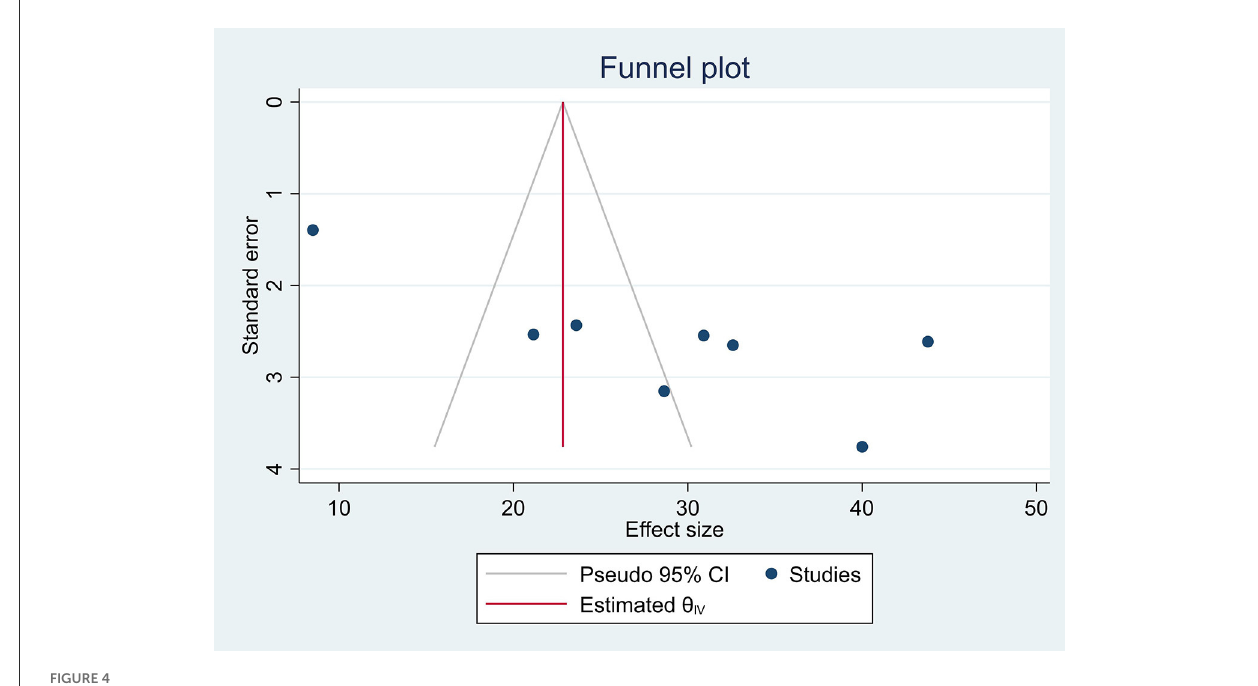
FIGURE4 Funnel plot.